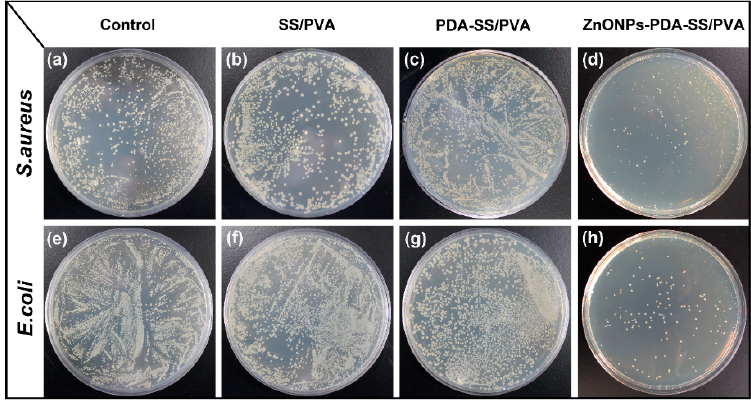
Figure 8. Antibacterial activity analysis of SS/PVA, PDA-SS/PVA and ZnO NPs-PDA-SS/PVA films against E. coli ( a – d ) and S. aureus ( e – h ).